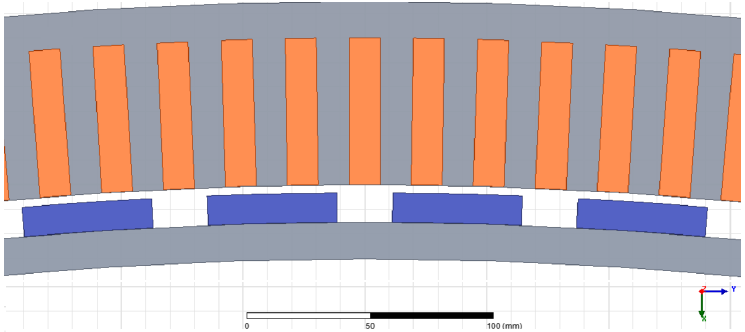
Figure 19. View of the designed (3:1) geared generator at the power rating of 1.5